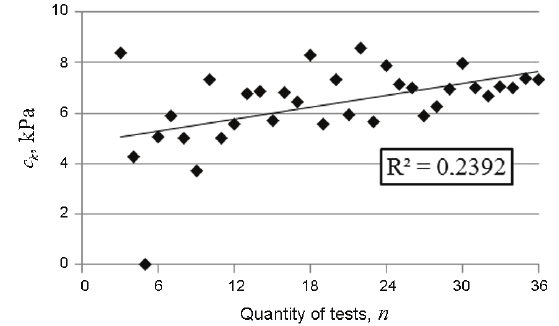
Fig. 7. Cohesion versus the quantity of tests according to random data